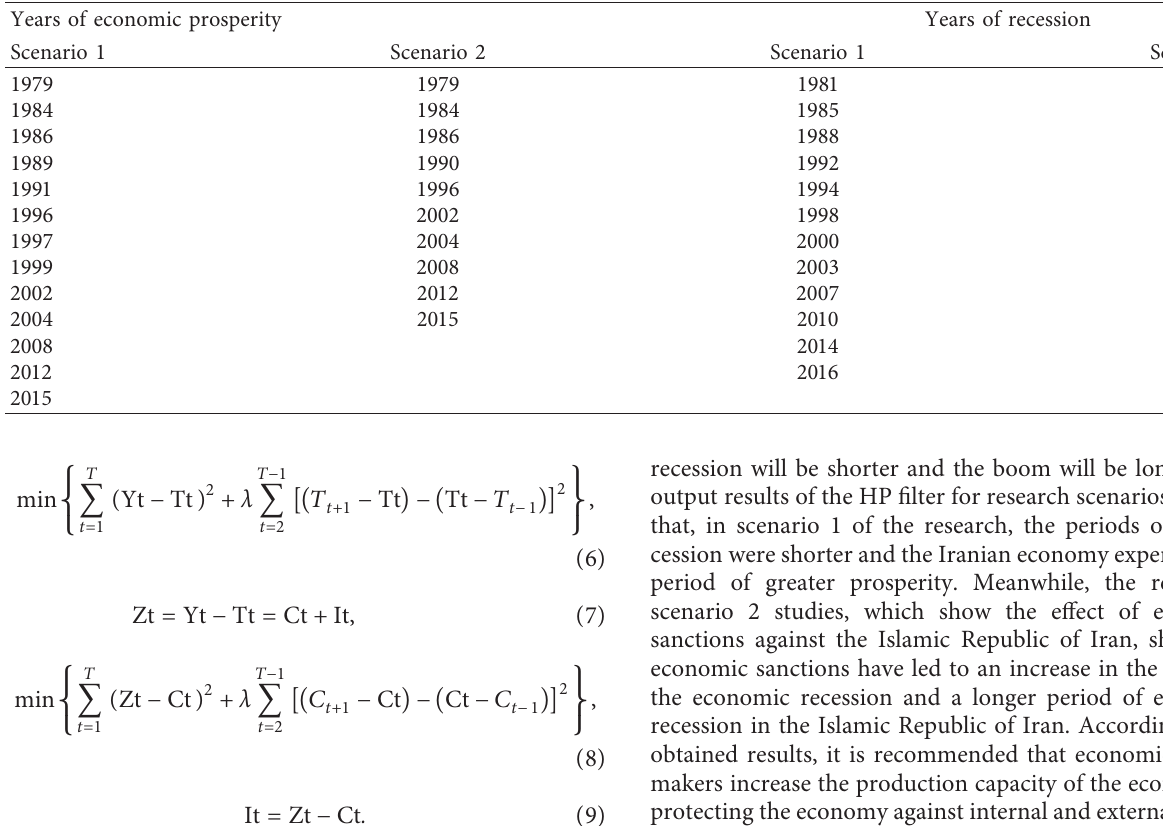
Table 7: The rate of prosperity and stagnation of scenario 1 and scenario 2